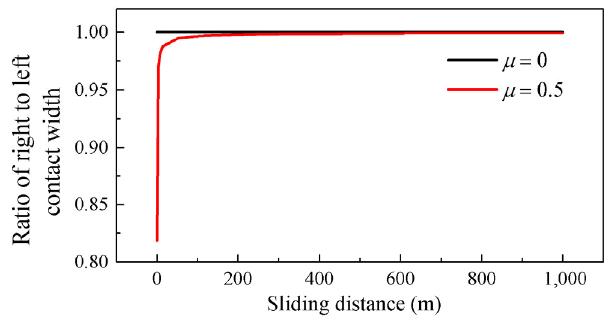
Fig. 11 Variation of ratio of right to left contact width with increasing sliding distance for 0  and 0.5  . The ring is assumed as a rigid body and the other simulation parameters are the same as in Section